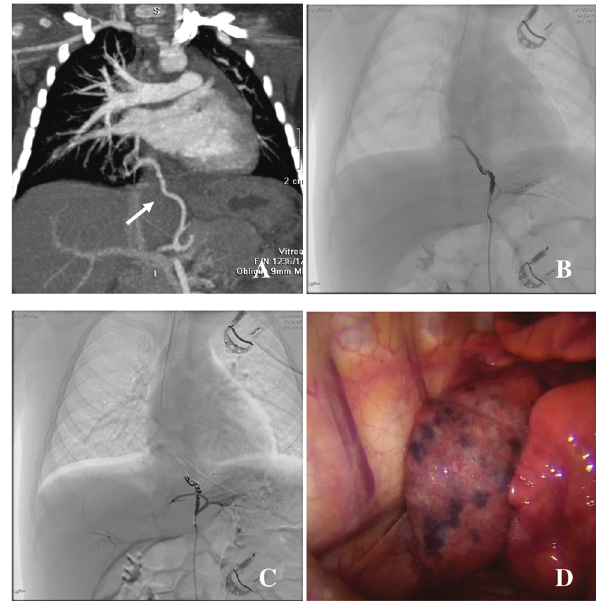
Fig. 2 1-year-old patient. ( A ) Preoperative chest CT with contrast; white arrow: aberrant feeding artery coming from celiac trunk. ( B ) “ Sub ” -embolization with coil, correct timing for methylene blue injection into the aberrant artery. ( C ) Complete embolization with coil (no downstream blood fl ow). ( D ) Intraoperative view, blue coloration of the sequestration and clear demarcation of healthy tissue, before marking and resection. CT, computed